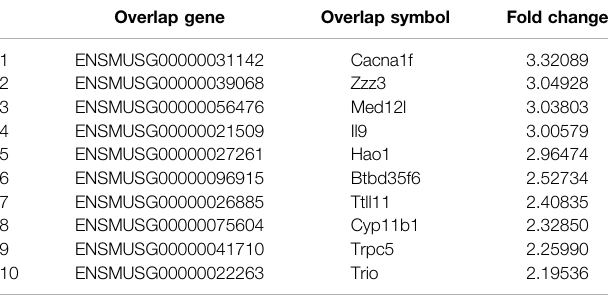
TABLE 2 | The low expression gene in osteoclastogenesis after treated with myostatin. Overlap gene Overlap symbol Fold change